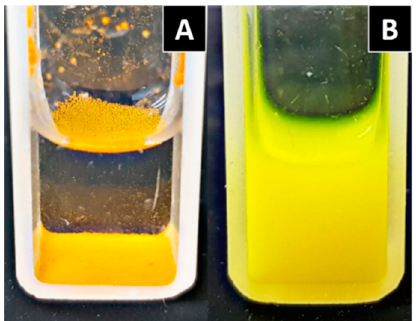
Figure 10. Curcumin solubility: ( A ) Curcumin showed poor solubility in aqueous medium; ( B ) the use of the nanoplatforms increased the drug solubility. Curcumin was entrapped in poly- ε -caprolactone nanoparticles stabilized by Pluronic F68 (Thermofisher, Whaltam, USA), with size of 170 nm and zeta potential of − 7